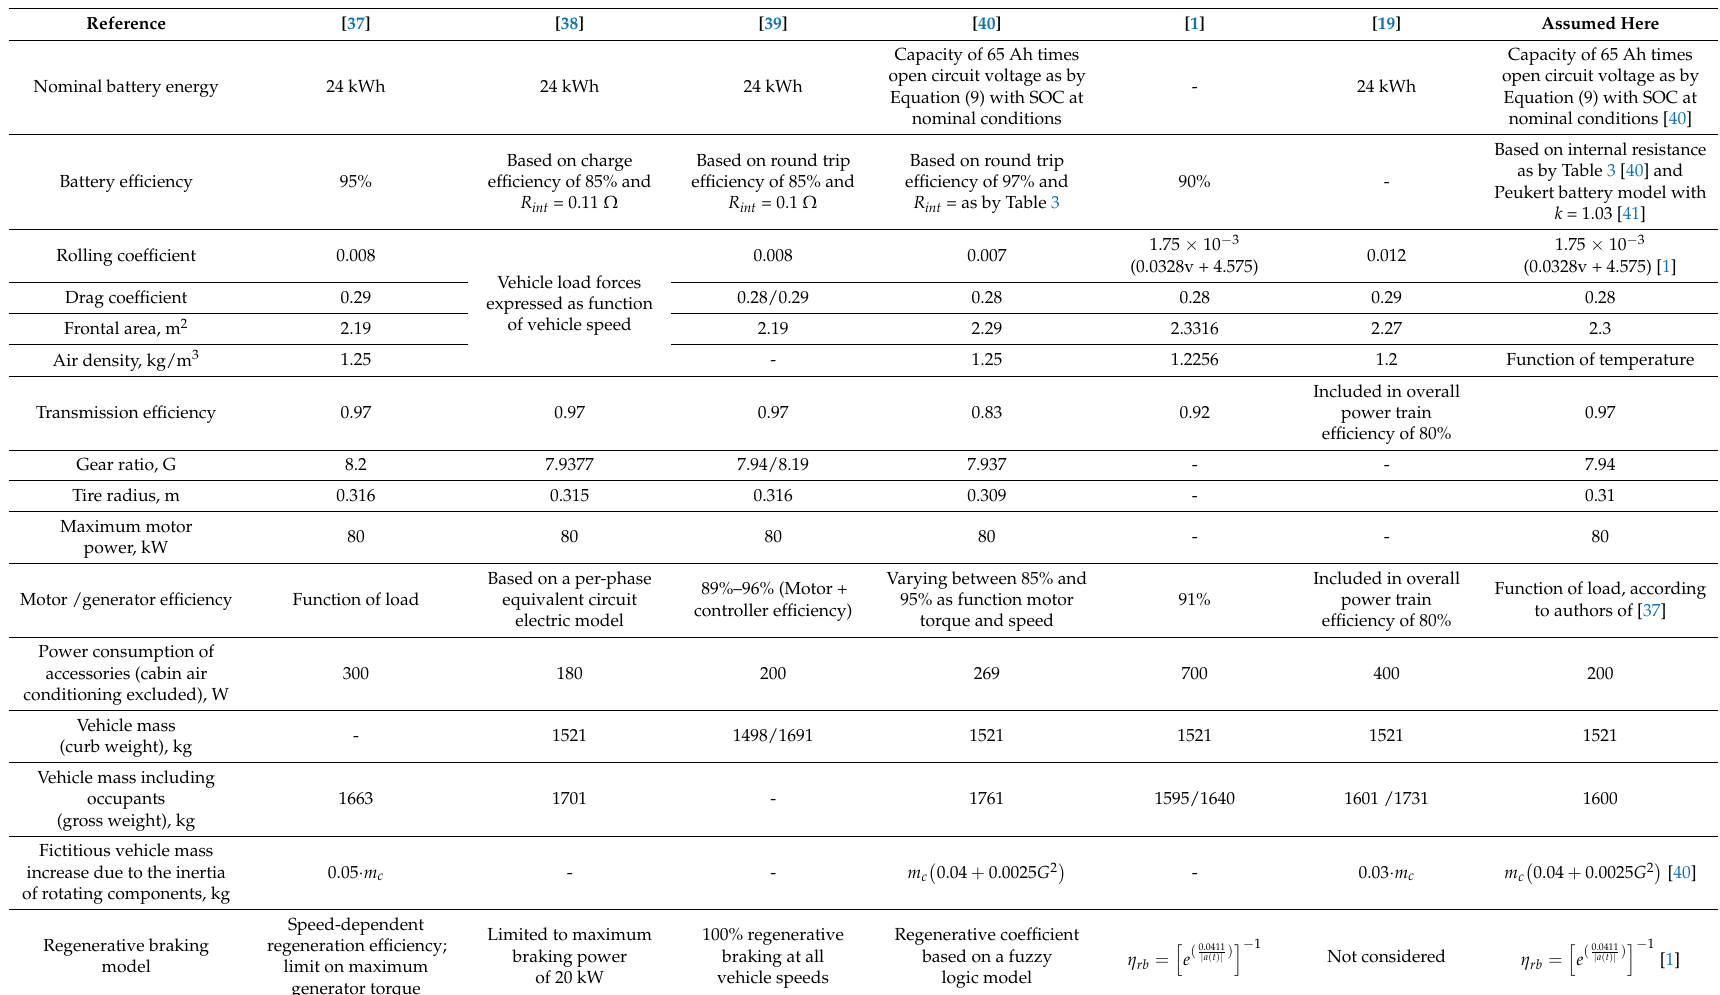
Table 1. Summary of the main assumptions adopted in various Nissan Leaf published models. SOC—state of